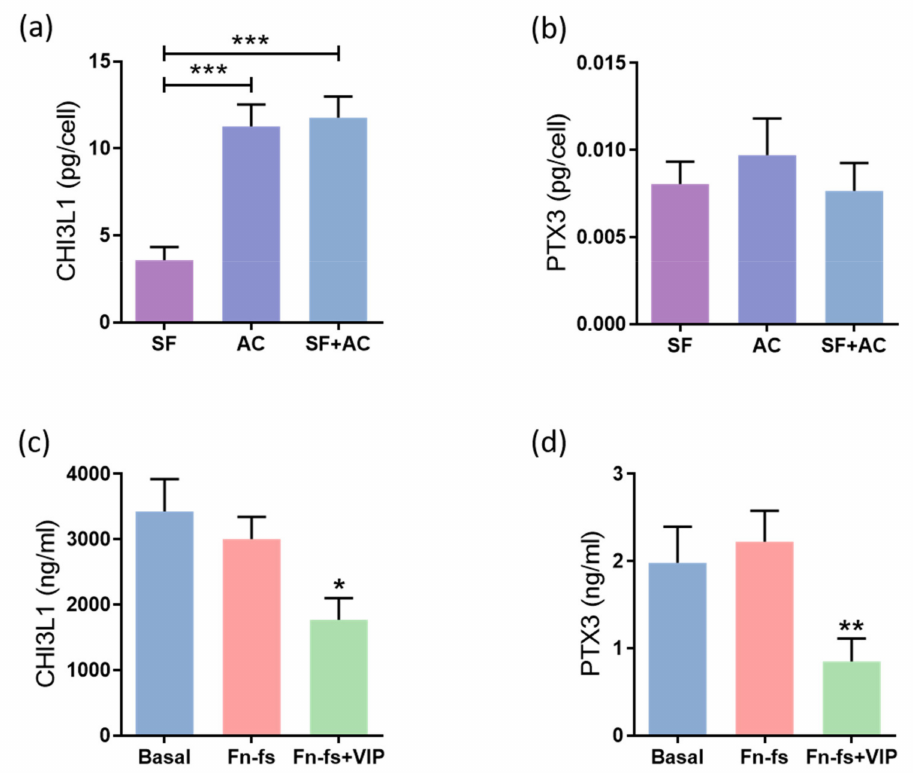
Figure 3. VIP-modulated inflammatory proteins. Secreted levels of ( a , c ) CHI3L1 and ( b , d ) PTX3 were determined by ELISA and Multiplex, respectively, in the secretomes from SF and AC alone and in co-culture ( n = 6). Data are presented as mean ± SEM of triplicate determinations. ( a , b ) Constitutive protein expression of ( a ) CHI3L1 and ( b ) PTX3 in the secretomes from SF and AC alone and in co-culture at 48 h. Results are presented as pg corrected by the number of cells for each condition. *** p < 0.001. ( c , d ) Protein expression of ( c ) CHI3L1 and ( d ) PTX3 in the SF-AC co-cultures secretomes at 48 h of treatment with and without 10 nM 45 kDa Fn-fs in the presence and absence of 10 nM VIP. * p < 0.05, ** p < 0.01 Fn-fs+VIP vs.